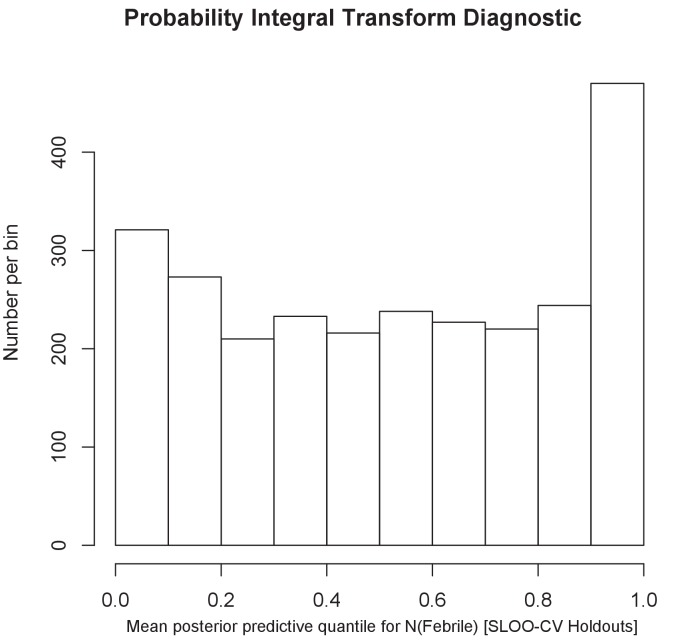
The histogram of the probability integral transform diagnostic.The uniform shape of the histogram shows that predictions at sites held out from the initial model drawn from the predicted posterior distribution for the prevalence of febrile illness matched well.